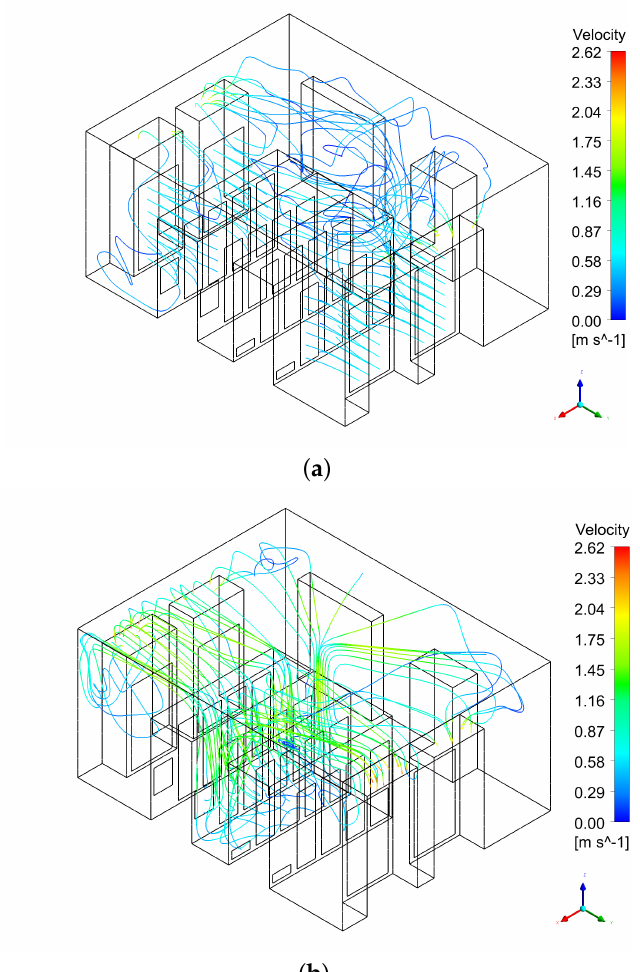
Figure 4. Streamlines originating from ( a ) the CRAC units and ( b ) the server racks when RSM is